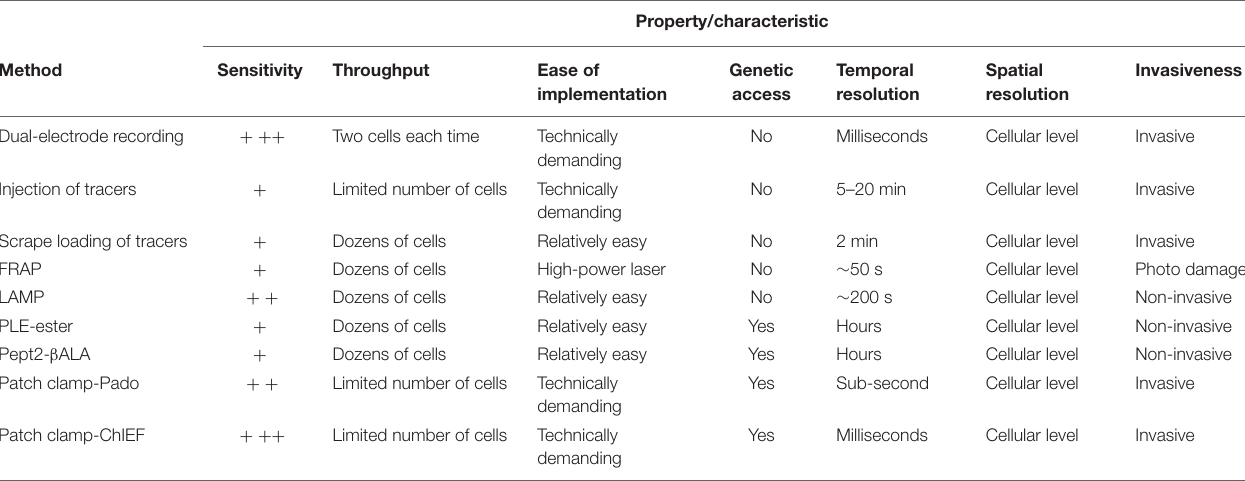
FIGURE 1 | Schematic overview of the currently available methods for studying gap junctions. The principle behind each method is shown schematically on the left with a radar graph on the right that summarizes its corresponding performance index (e.g., sensitivity, throughput, resolution) in arbitrary units ranging from 0 to 4. Further details are provided in the text. FRAP, fluorescence recovery after photobleaching; LAMP, local activation of a molecular fluorescent probe; PLE, porcine liver esterase; Pept2, peptide transporter 2; β ALA, AMCA-labeled dipeptides β -Ala-Lys; ChIEF, an engineered version of a channelrhodopsin. TABLE 1 | Overview of the methods used to probe gap junctional